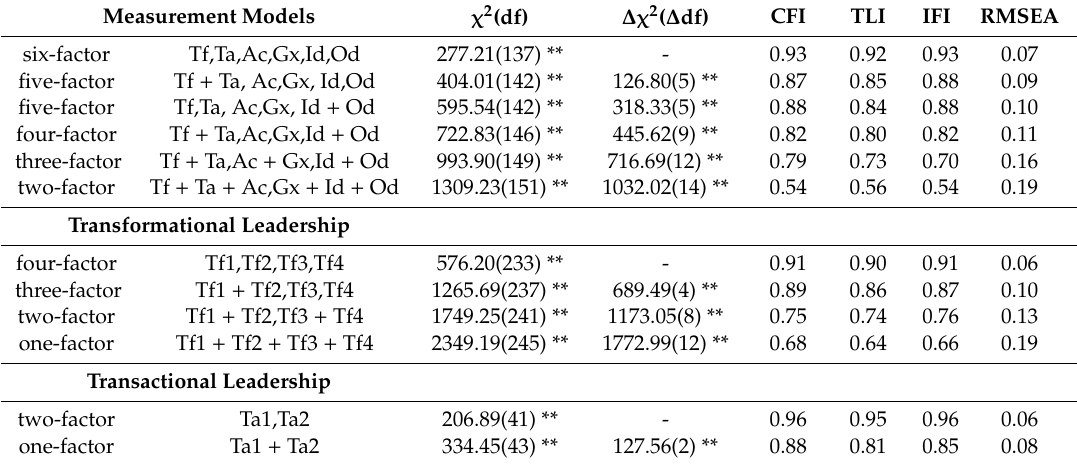
Table 1. The results of confirmatory factor